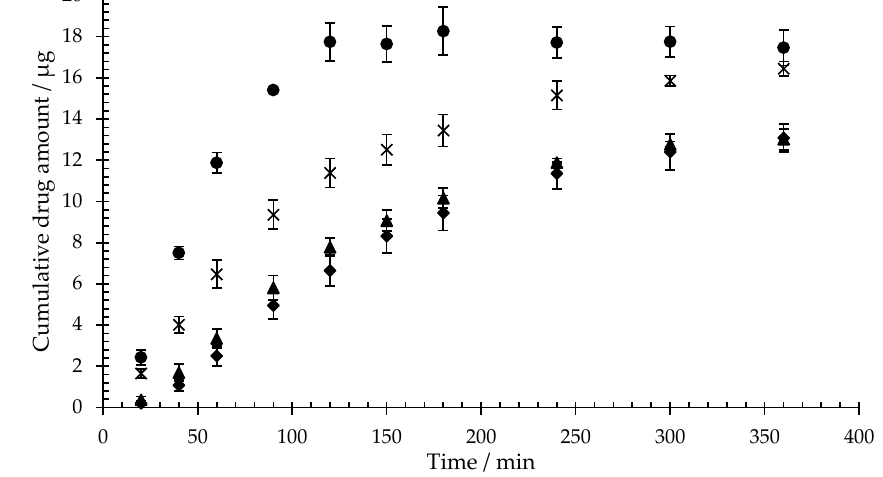
Figure 4. Cumulative di ff usion of 20 µ g sodium fluorescein across a mixed cellulose ester membrane covered with hydrogel samples or artificial saliva (300 µ L) over 6 h, • artificial saliva, (cid:7) 0.23 g lozenge / mL, (cid:78) 0.115 g lozenge / mL, and × 0.077 g lozenge / mL. Mean ± standard deviation. Each sample was measured in